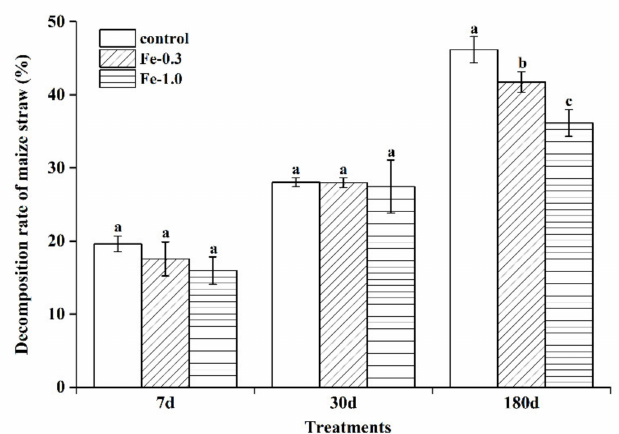
Figure 1. Temporal variations in the decomposition rate of maize straw. Different letters on the bars indicate the significant differences ( p < 0.05) among the treatments.